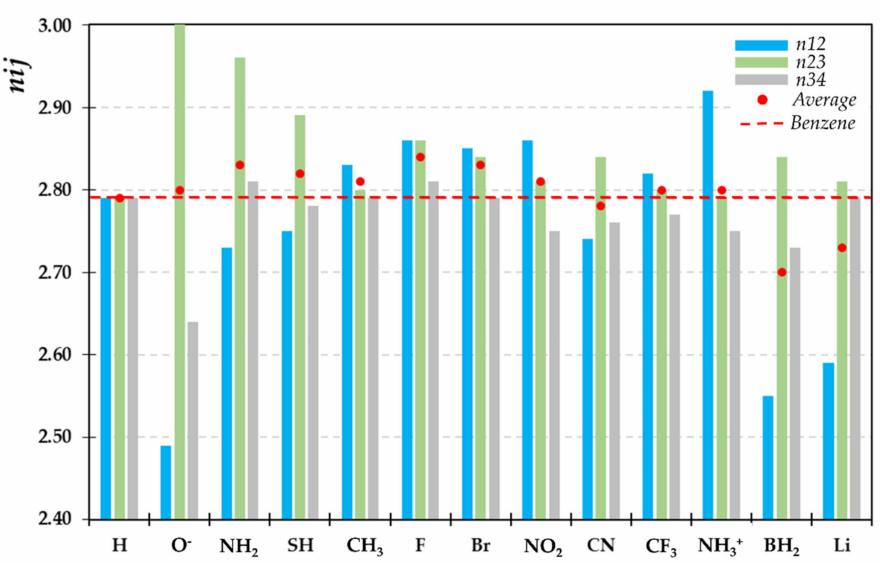
Figure 2. bij basin populations ( nij ) for the selected set of Ph–X systems. All data in au. Notice that n23 for X = O − is equal to 3.29, but it has been cut at 3.00 for visual